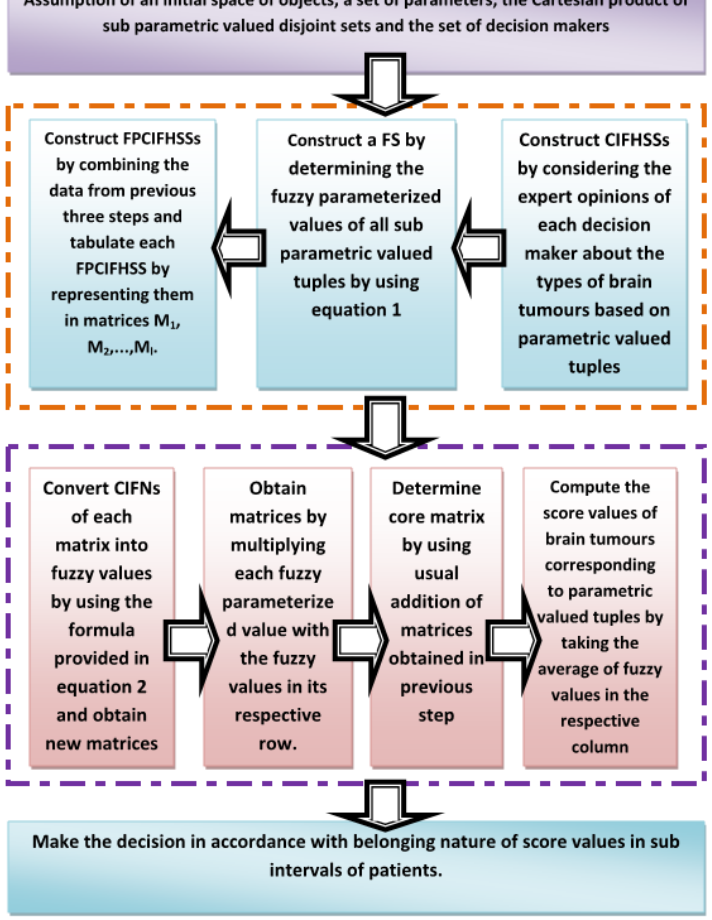
Figure 4. Flowchart of proposed PMBSA